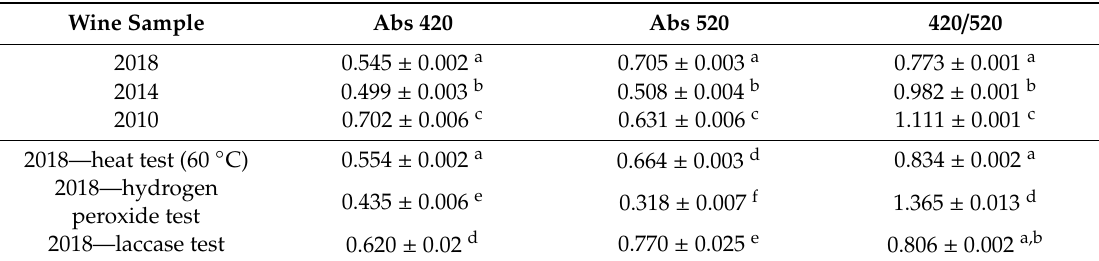
Figure 3. Absorbance measurements (400–800 nm) for six di ff erent wine samples: three untreated wines from di ff erent vintages (2018, 2014 and 2010) and three from 2018 vintage artificially oxidized. Data are available in supplementary data: Tables S14–S19. Table 3. Mean of three replicates ± standard error. Means in the same column with different lowercase letters are significantly different (Tukey test, α = 0.05).